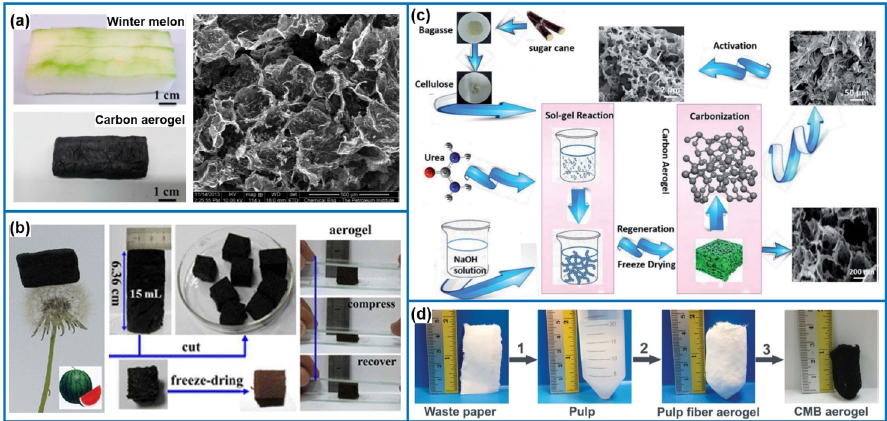
Figure 7. Carbon aerogels derived from different biomass: ( a ) Winter melon, reproduced with permission of [156] (Copyright American Chemical Society 2014). ( b ) Watermelon, reproduced with permission of [158] (Copyright American Chemical Society 2013). ( c ) Bagasse, reproduced with permission of [159] (Copyright The Royal Society of Chemistry 2014). ( d ) Waste paper, reproduced with permission of [160] (Copyright Wiley ‐ VCH Verlag GmbH & Co. 2014).